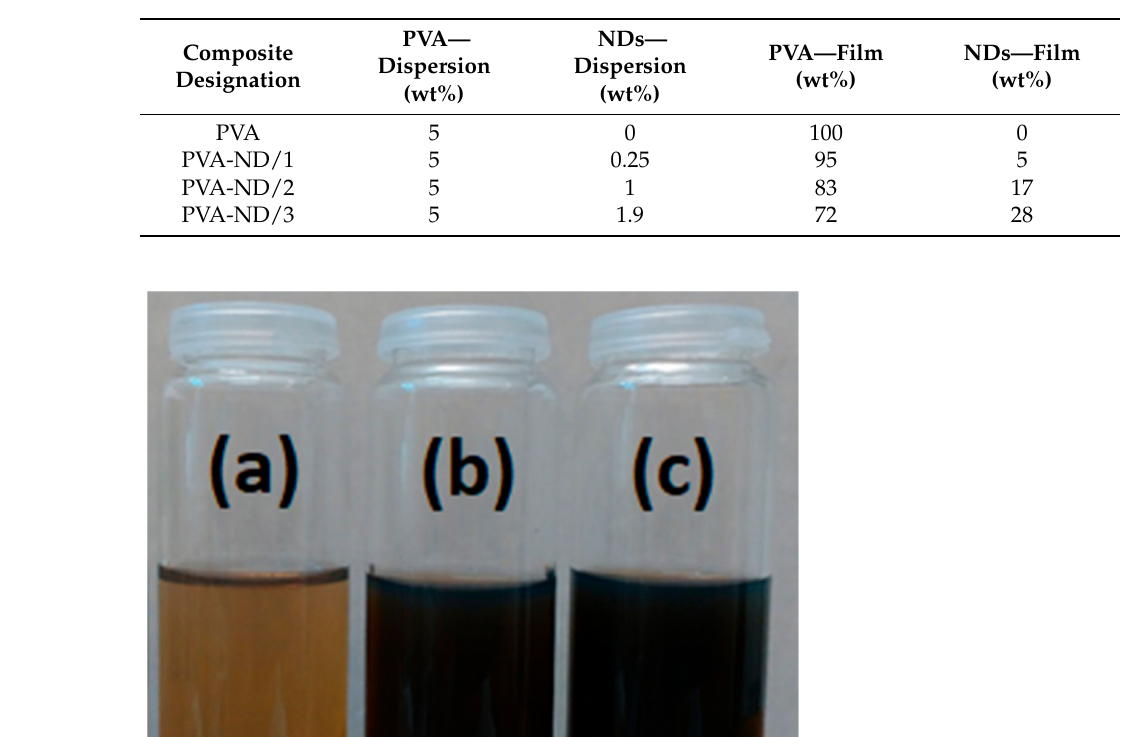
Table 1. Composition of the vinyl alcohol-nanodiamonds (PVA-ND) dispersions and dried PVA-ND nanocomposite films.